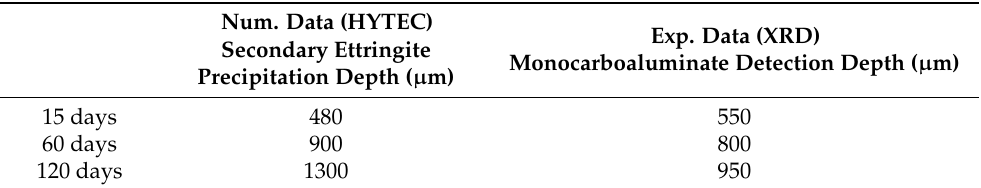
Table 4. Comparison between the monocarboaluminate limit-detection depth deduced from the XRD results with the ettringite precipitation calculated depth obtained from the HYTEC simulation.